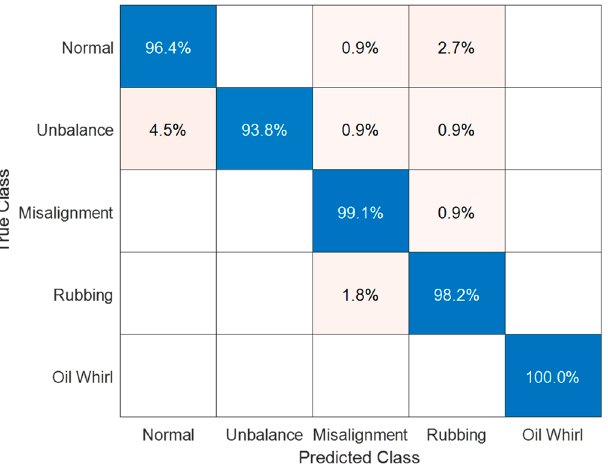
Figure 17. Training/validation confusion matrix of SVM (cubic) on automatically extracted features from the pretrained deep learning model with 12 virtual sensors on RK4.